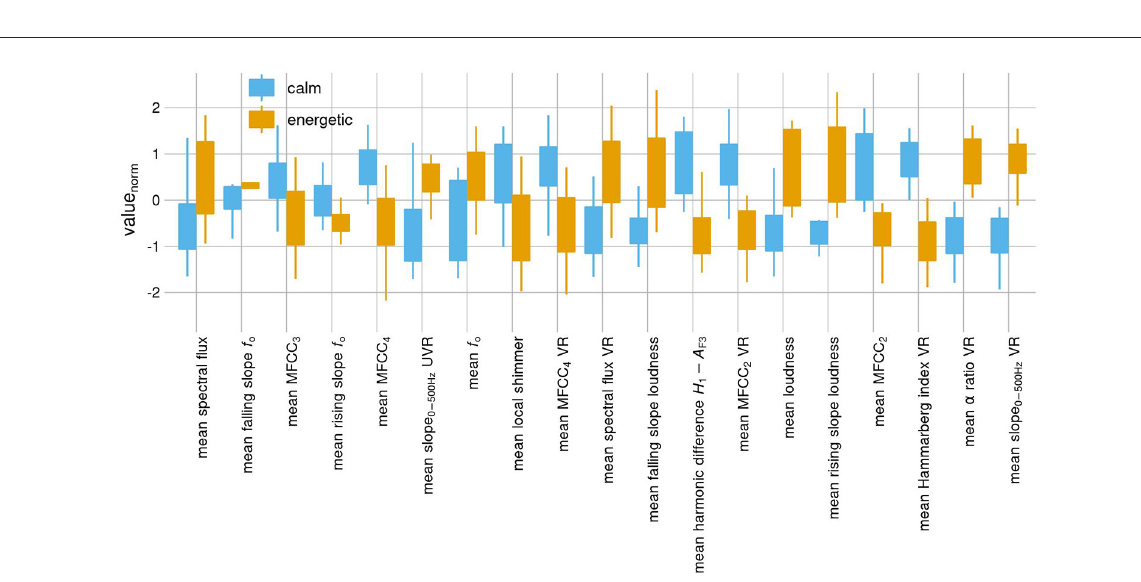
FIGURE3 The acoustic parameters differentiating the advertising styles. Spectral parameters: slope 0–500Hz = linear regression slope of the logarithmic power spectrum for 0–500Hz region, alpha ratio = ratio of the summed energy from 50–1000Hz, Hammarberg index = the ratio of the strongest energy peaks in the 0–2kHz vs 2–5kHz regions, MFCC 2,3,4 = second, third, and fourth Mel-frequency cepstral coefficient; harmonic difference H 1 - A F3 = ratio of energy of the first f 0 harmonic ( H 1 ) to the energy of the highest harmonic in the third formant range ( A 3 ), spectral flux = difference of the spectra of two consecutive frames; Energy/Amplitude related parameters: loudness = estimate of perceived signal intensity from an auditory spectrum, rising/falling slope loudness = slope of rising/falling signal parts of loudness, shimmer = difference of the peak amplitudes of consecutive